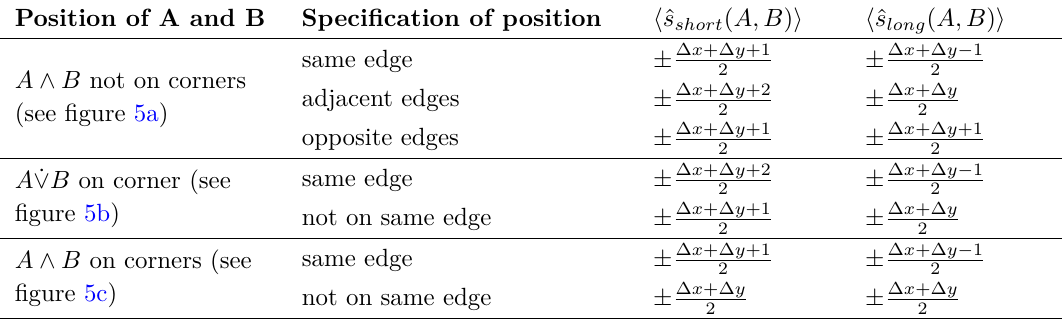
Table 2. Constraints that an array Z has to verify to represent a physical